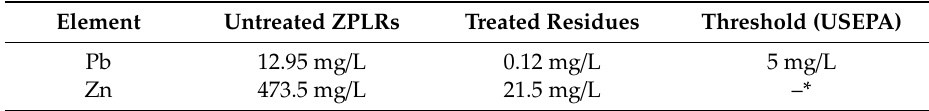
Table 2. Toxicity characteristic leaching procedure (TCLP) leachability tests of untreated ZPLRs and treated residues after concurrent dissolution and cementation treatment.